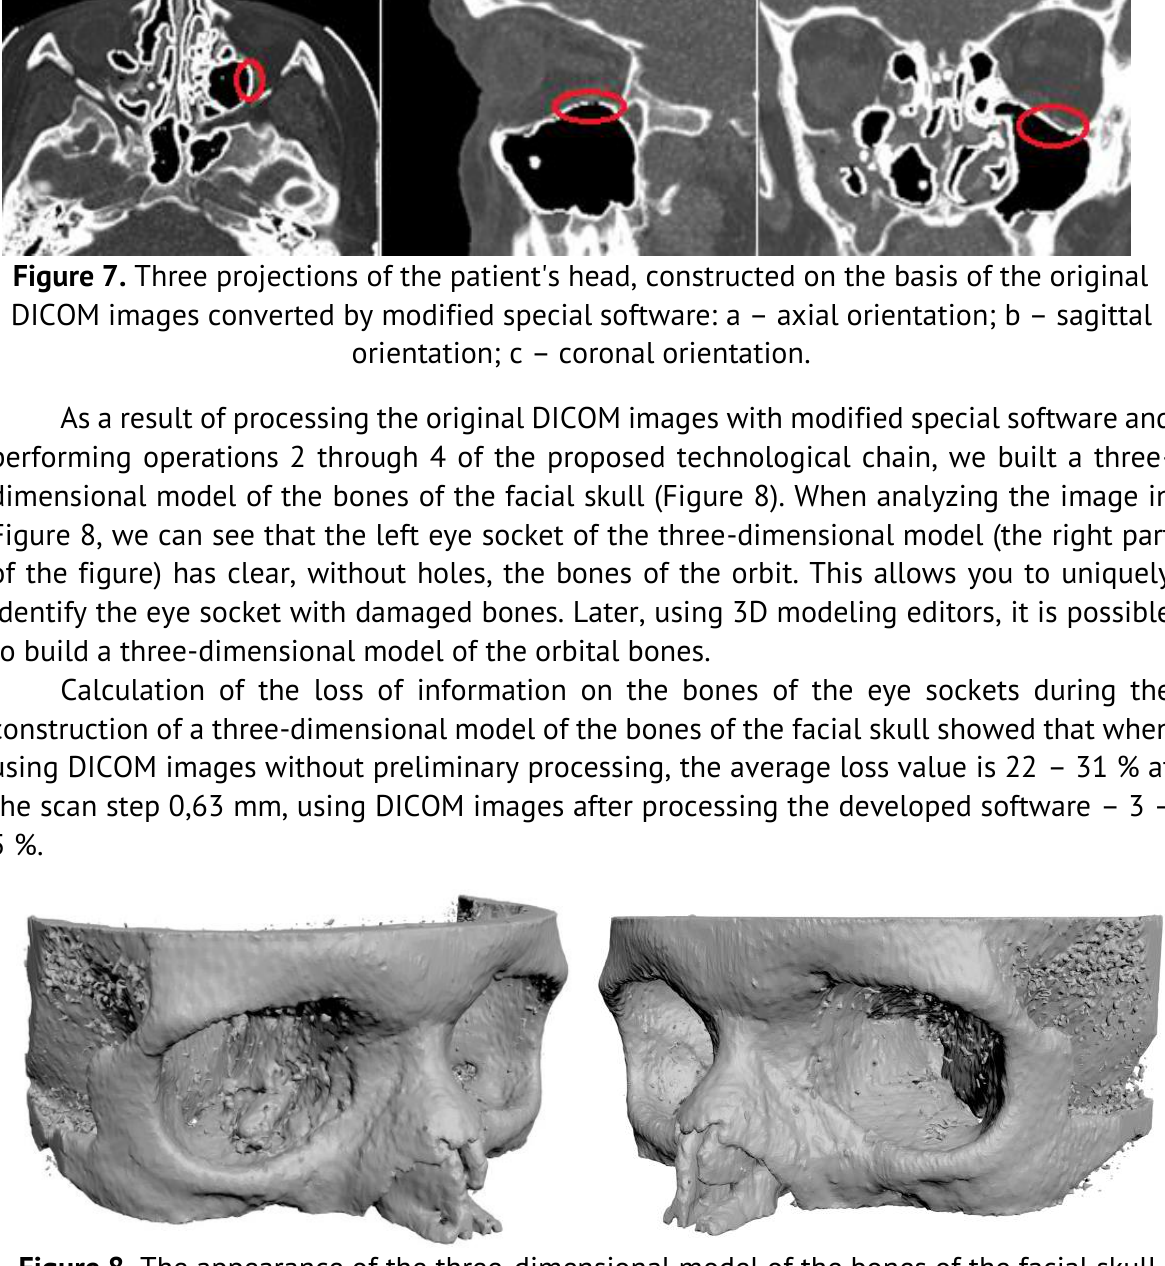
Figure 8. The appearance of the three-dimensional model of the bones of the facial skull after processing by special software: the result of construction by a 3D